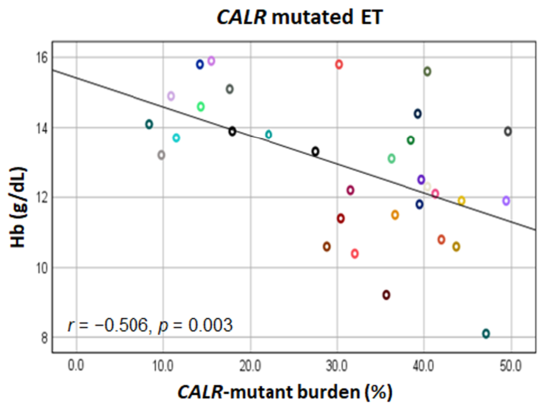
Figure 3. Scatter plots between CALR -mutant burden and hemoglobin (Hb) level in patients with CALR -mutated CALR -mutated ET.